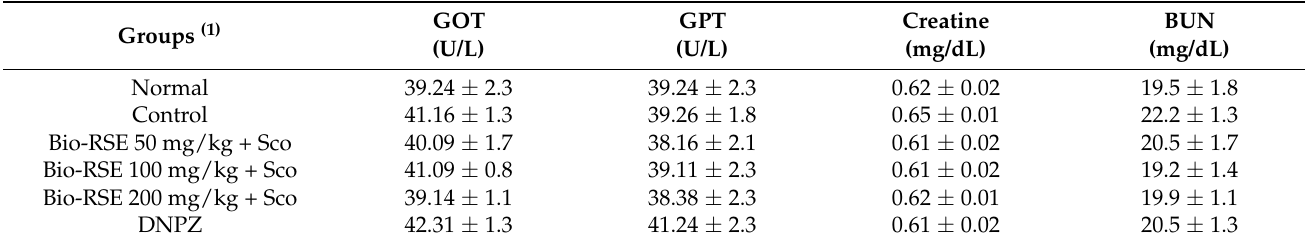
Table 4. Serum transaminase activity, creatinine, and BUN levels in each